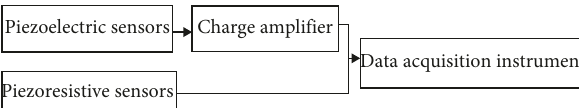
Figure 4: Measurement system used in the experiment.